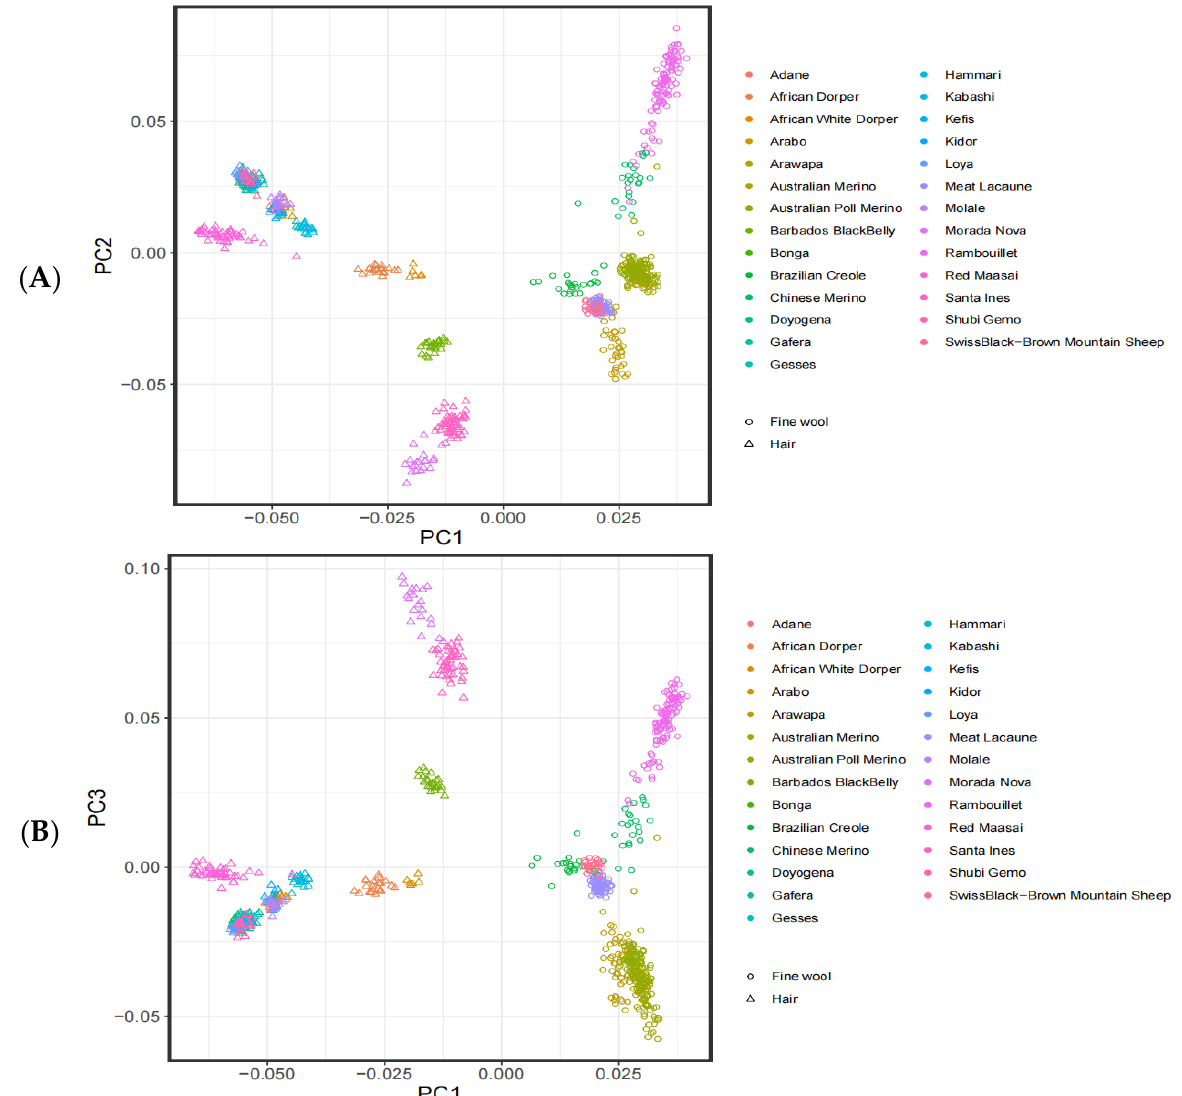
Figure 1. Principal component analysis of the different sheep populations. ( A ) Analysis results of PC1 and PC2 between the fine-wool sheep and hair sheep populations; ( B ) Analysis results of PC1 and PC3 between the fine-wool sheep and hair sheep populations.